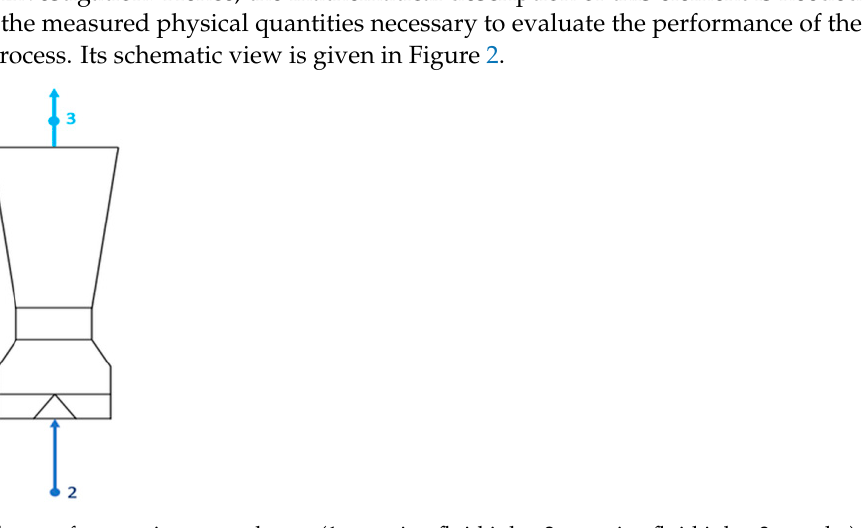
Figure 2. Scheme of spray-ejector condenser (1—suction fluid inlet, 2—motive fluid inlet, 3—outlet). SEC has two inlets (for suction fluid and motive fluid) and one outlet. In case of water and steam SEC, according to energy balance, heat given by steam (suction fluid) is equal to heat absorbed by cooling water (motive fluid). From this, we obtain